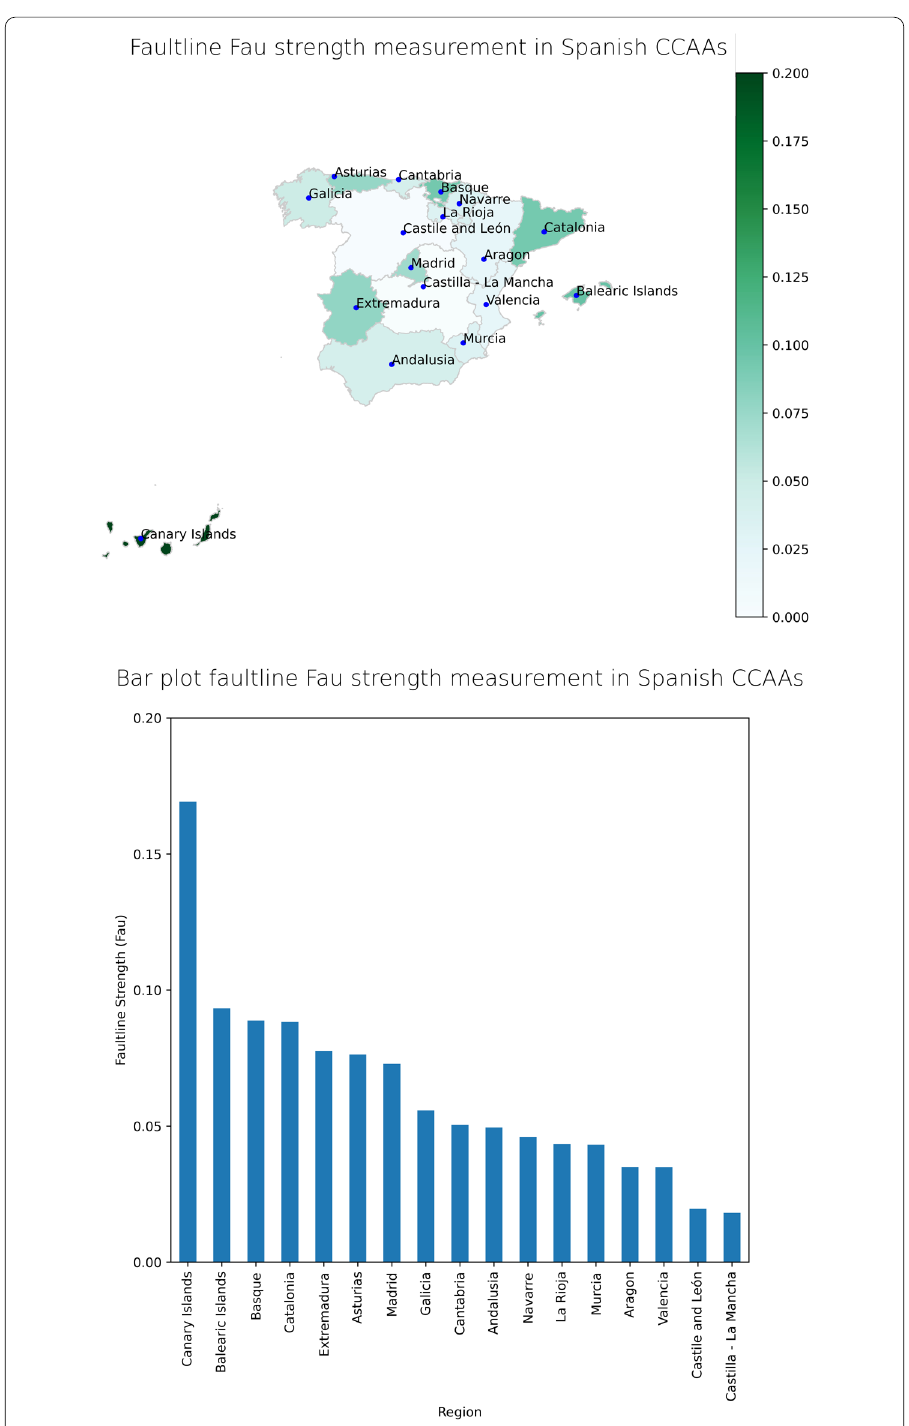
Figure 4 Faultline strength analysis